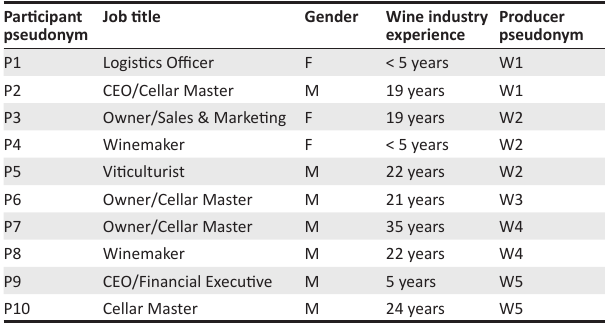
TABLE 3: Profiles of the study participants.